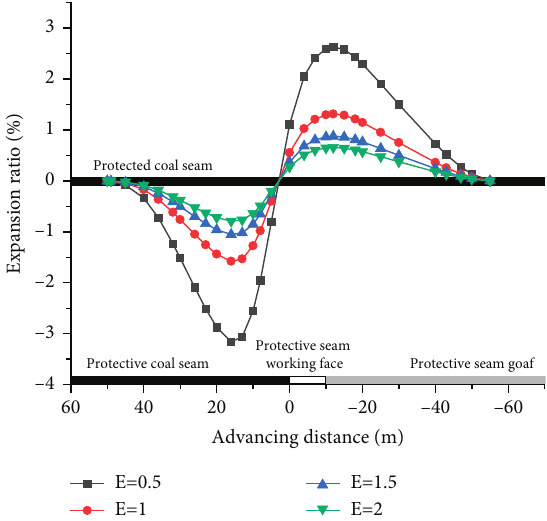
Figure 7: Variation curve of expansion rate with different elastic